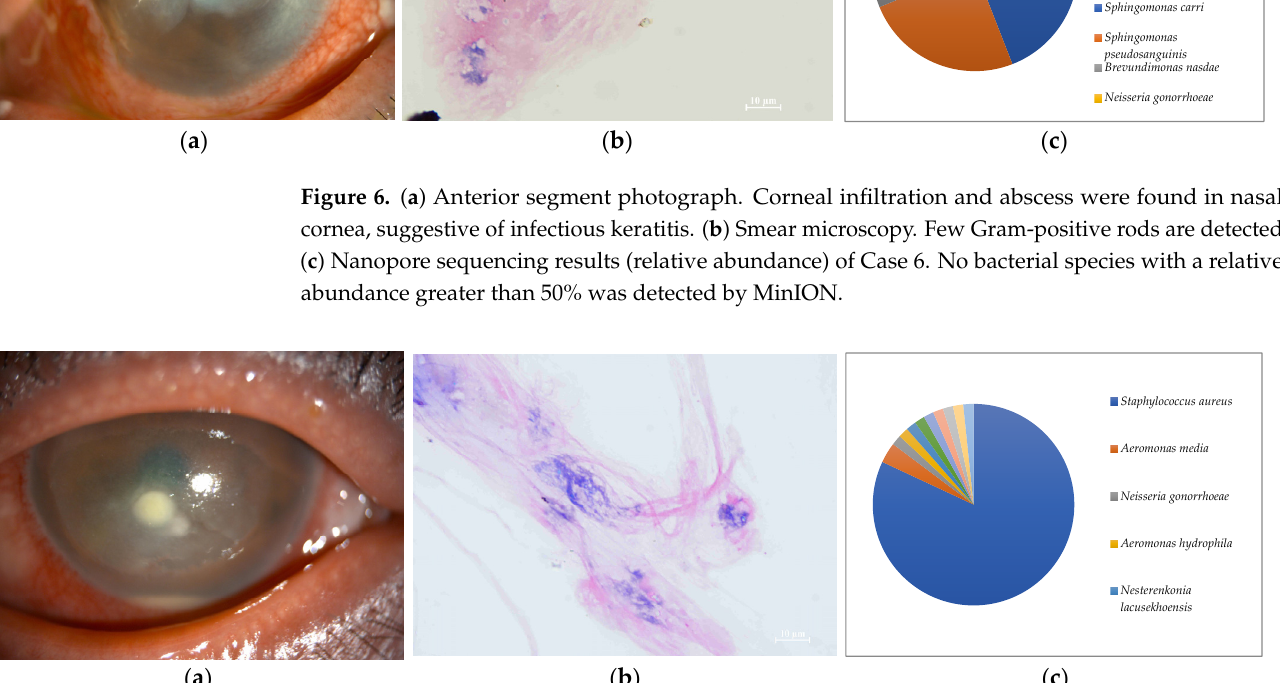
Figure 7. ( a ) Anterior segment photograph. Corneal infiltration and corneal abscess were found, suggestive of infectious keratitis. ( b ) Smear microscopy. No organisms were detected by Gram staining. ( c ) Nanopore sequencing results (relative abundance) of Case 7. An overwhelming majority of Staphylococcus aureus was detected by MinION.